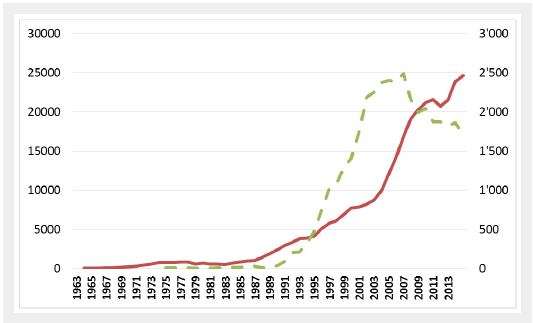
Evolution of publications about “biomedical informatics” compared with “genetic therapy” according to Pubmed. This figure illustrates the evolution of publications indexed in Pubmed with the MeSH term “medical informatics [MeSH]” (left axis, full line red) and “genetic therapy [MeSH]” (right axis, dotted line grey) between 1963 and 2013 as of 3 March 2015. The years 2014 and 2015 are left out to avoid bias of publication and indexing